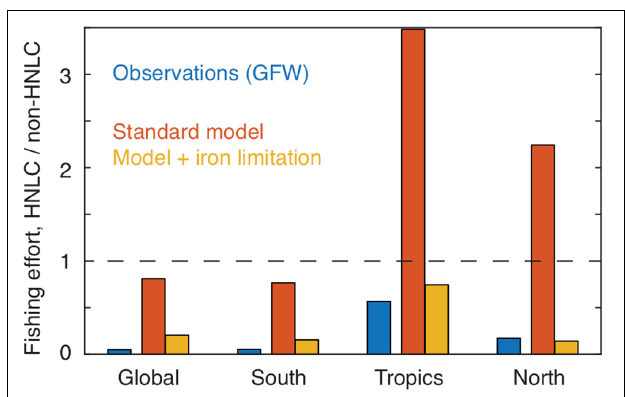
FIGURE 6 | Comparison of observed and modeled fishing effort in HNLC vs. non-HNLC domains. A value of unity (dashed line) indicates the same average fishing intensity in the two domains. The standard model (red) does not show a significant difference in effort between HNLC and non-HNLC domains at the global scale, and actually shows relatively high effort in HNLC waters of the tropics and northern hemisphere. In contrast, both the Global Fishing Watch observations (blue) and the iron-limited model (orange) show lower effort in HNLC regions relative to non-HNLC regions. Latitude ranges are given in Table 1 . EEZs are excluded from the